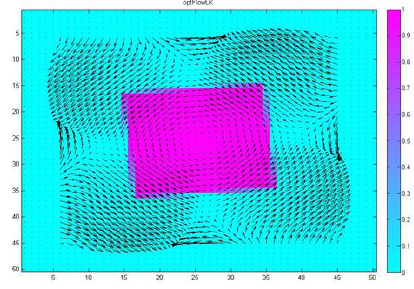
Figure 19. Results of Lucas/Kanade (Win=5, Sigma=2)